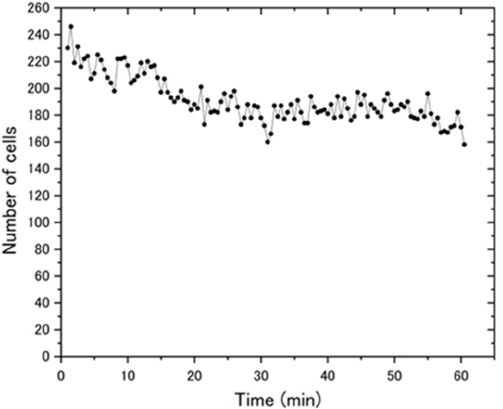
Figure 3. Change over time in the number of cells within the observation area.